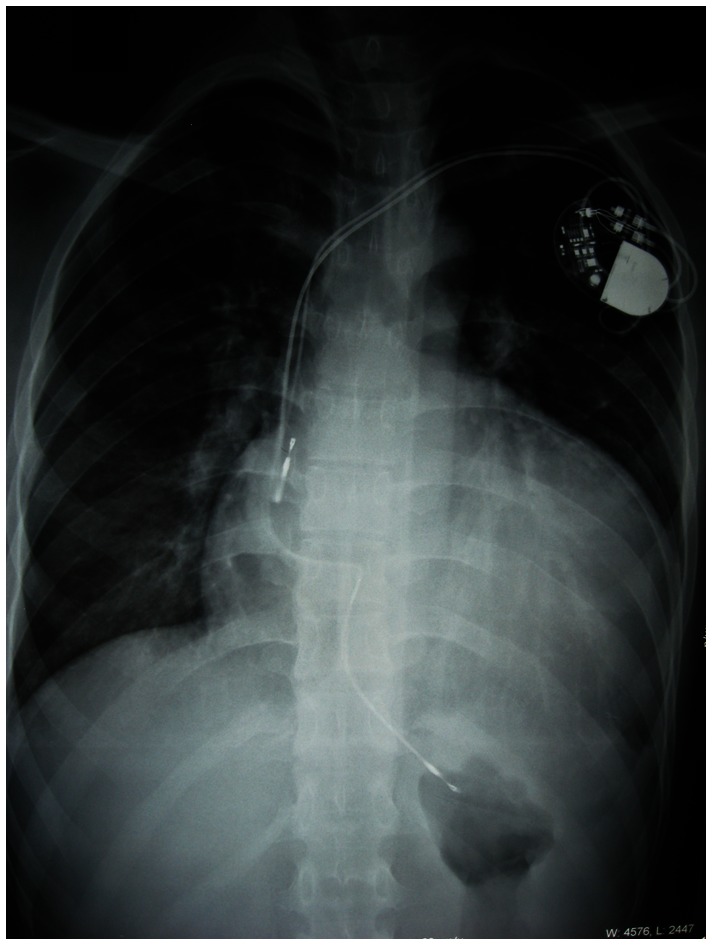
Postero-anterior chest radiograph of the proband after permanent pacemaker implantation.It shows severe cardiomegaly with a cardiothoracic rate of 70.6%.